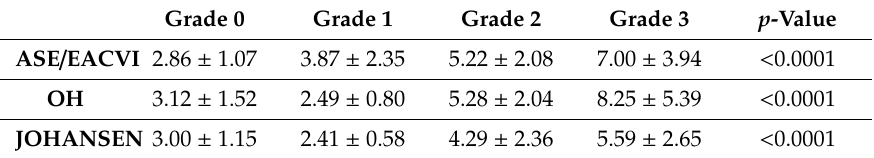
Table 2. Values of LAVi / a’ for grades of diastolic dysfunction according to di ff erent algorithms. Grade 0 Grade